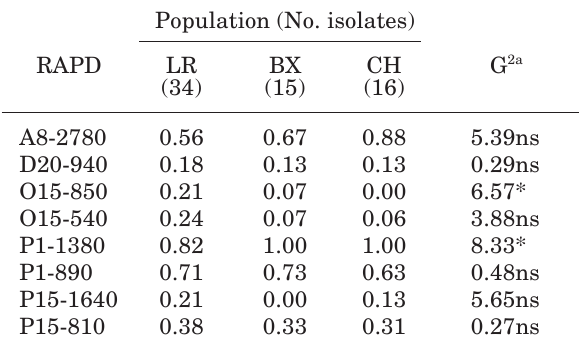
Table 7. Frequency of eight RAPD markers and differ- entiation in Phaeoacremonium aleophilum populations from Languedoc-Roussillon (LR), Bordelais (BX) and Charentes (CH)